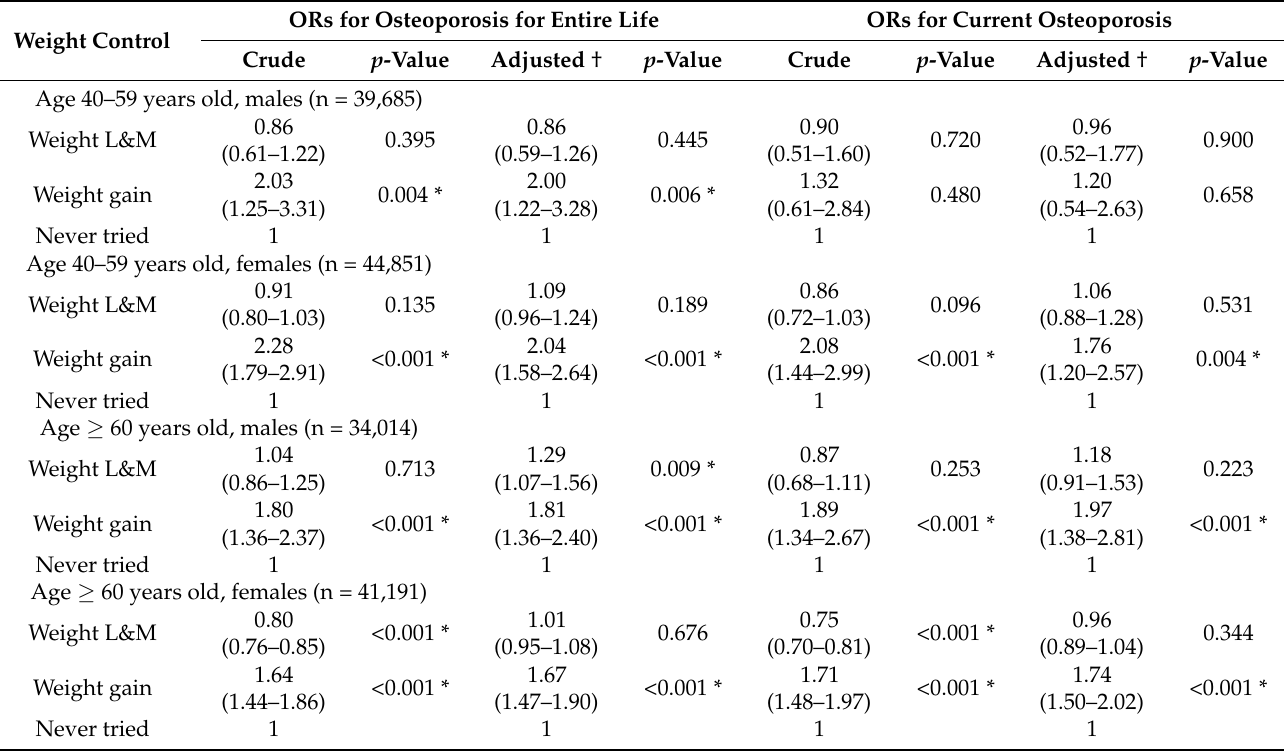
Table 3. Subgroup analysis of crude and adjusted odd ratios (95% confidence interval) of weight control for osteoporosis according to age and